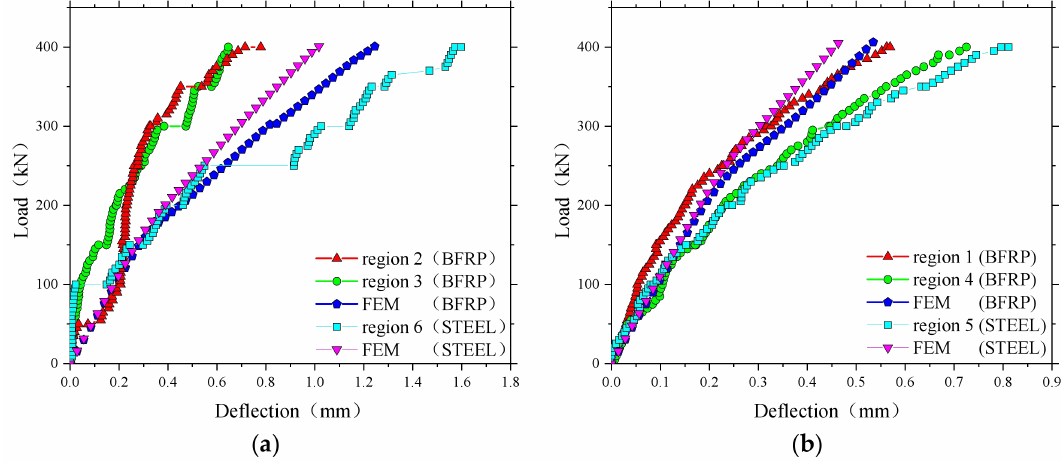
Figure 16. Comparison of load–displacement responses obtained from the experimental test and the finite element method (FEM). ( a ) Loading between the W-beams; ( b ) Loading between W-beams and W-beams.